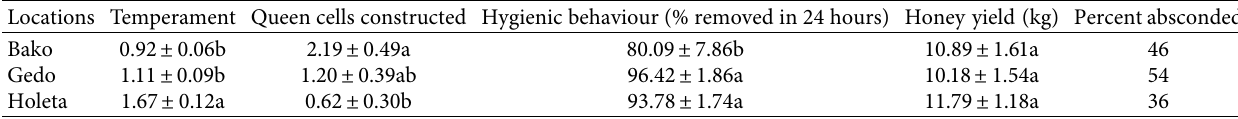
Table 2: Running behaviour scores, swarming and hygienic behaviour, honey yield, and percentages of absconding (mean ±